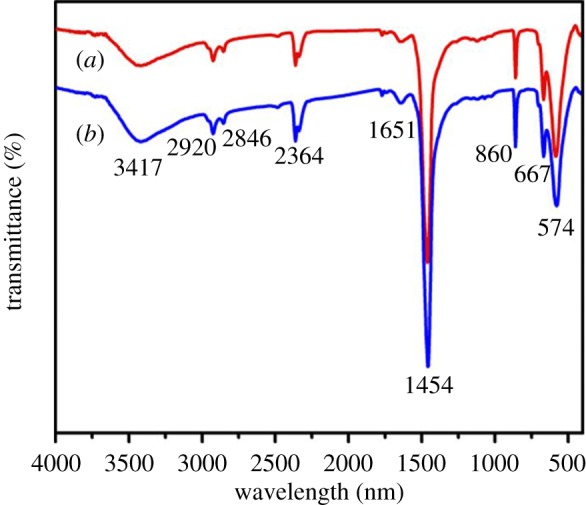
FT-IR spectra of fresh (a) and re-used (b) La0.6Sr0.4CoO3 perovskite catalysts.